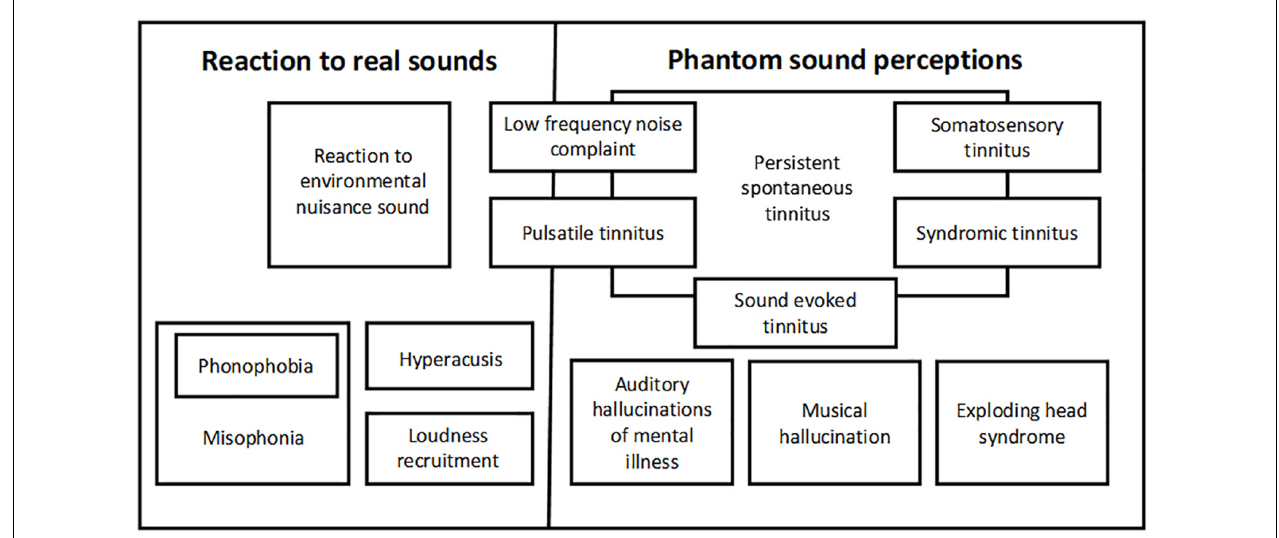
FIGURE 3 | The forms of negative reaction to real and phantom